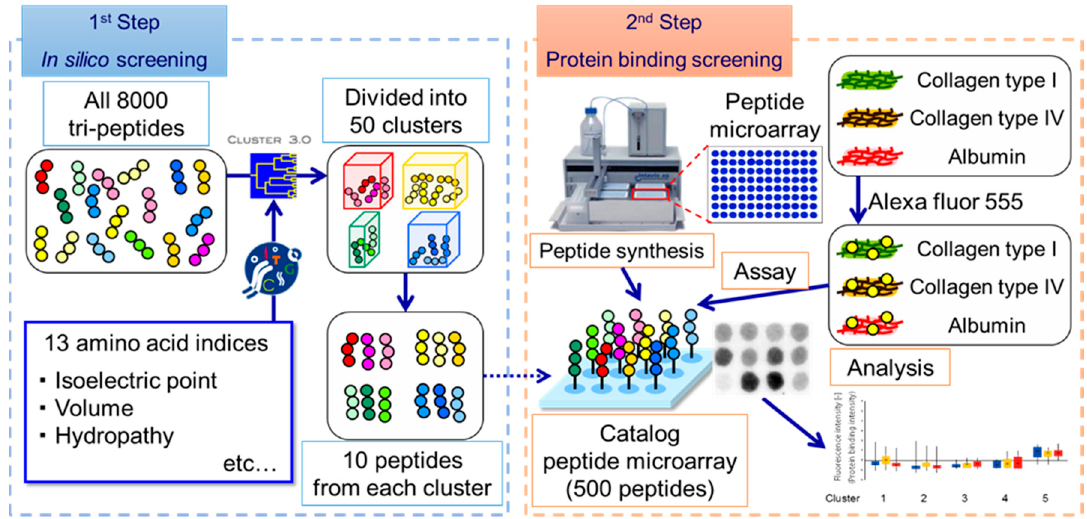
Figure 1. Schematic illustration of our concept for screening for ECM-selective (extracellular matrix) adhesion peptides. The method is divided into two sequential steps. The first step involves in silico screening of tripeptides. Peptide sequences are categorized according to 13 amino acid indices and are clustered in silico into 50 groups of physicochemically similar peptides. Ten representative peptides are then selected from each cluster. In the second step, these representative sequences are synthesized on the candidate array. In our assay for detecting ECM-selective peptides, microarray intensities indicate the normalized, relative strengths of protein adhesion to Col IV (collagen type), Col I, and Alb. Finally, the results are analyzed to identify Col IV-selective adhesion peptides.